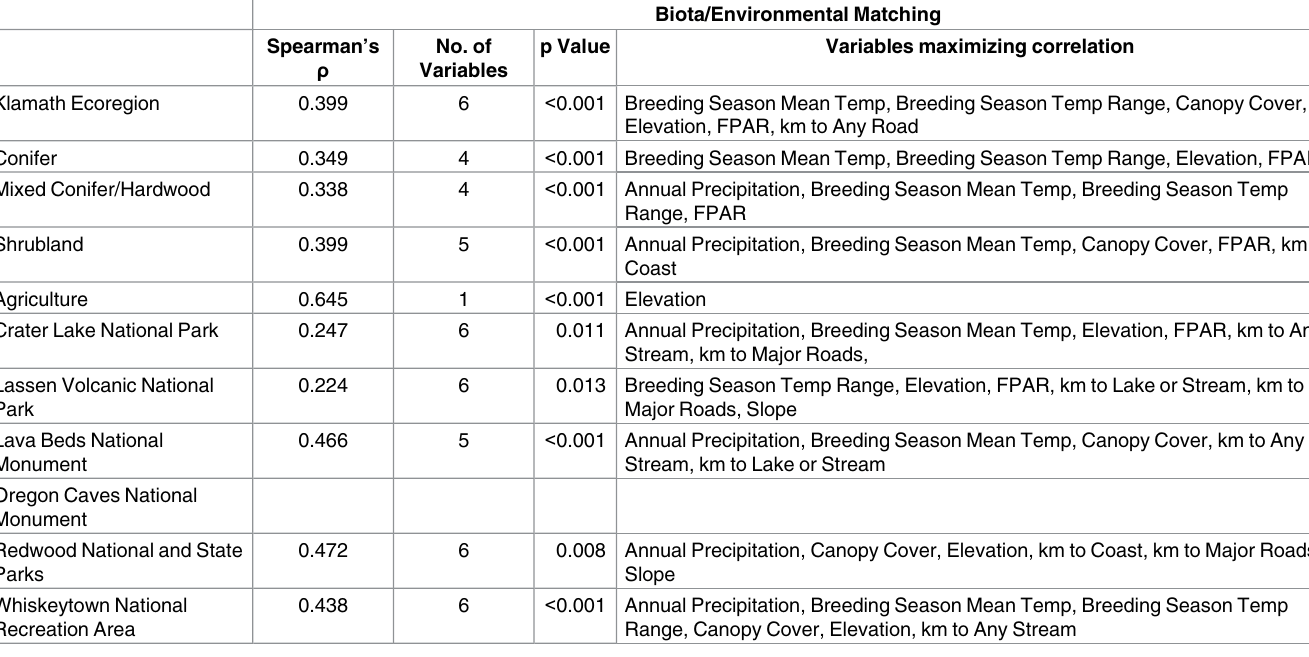
Subsets of environmental variables maximizing the correlation between bird sites and environmental variables (BIOENV). See methods for additional explanation and S2 Table for more information on environmental